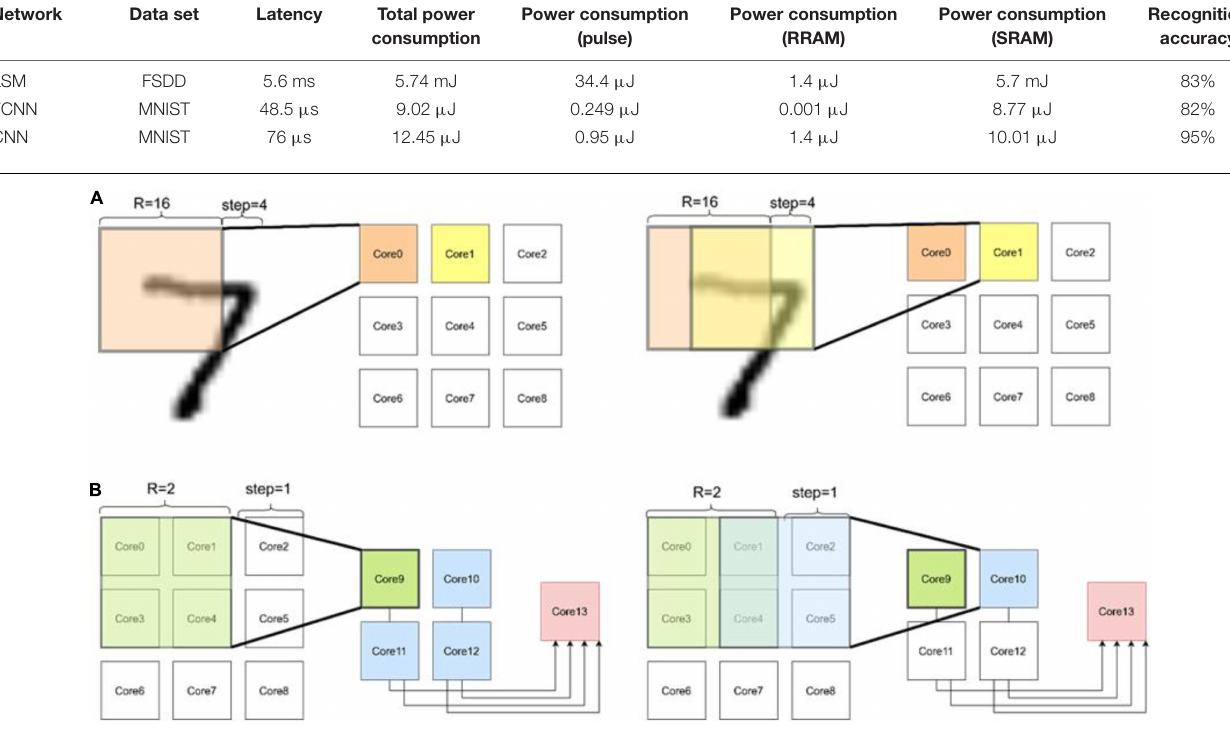
FIGURE 5 | CNN for MNIST. This is the operation process of a three-layer network on the chip. (A) In the first layer, the convolution results generated by each slide are put into a separate core. (B) The second layer convolved the data of four adjacent cores simultaneously. Finally, all the generated data is routed to one core for full connection